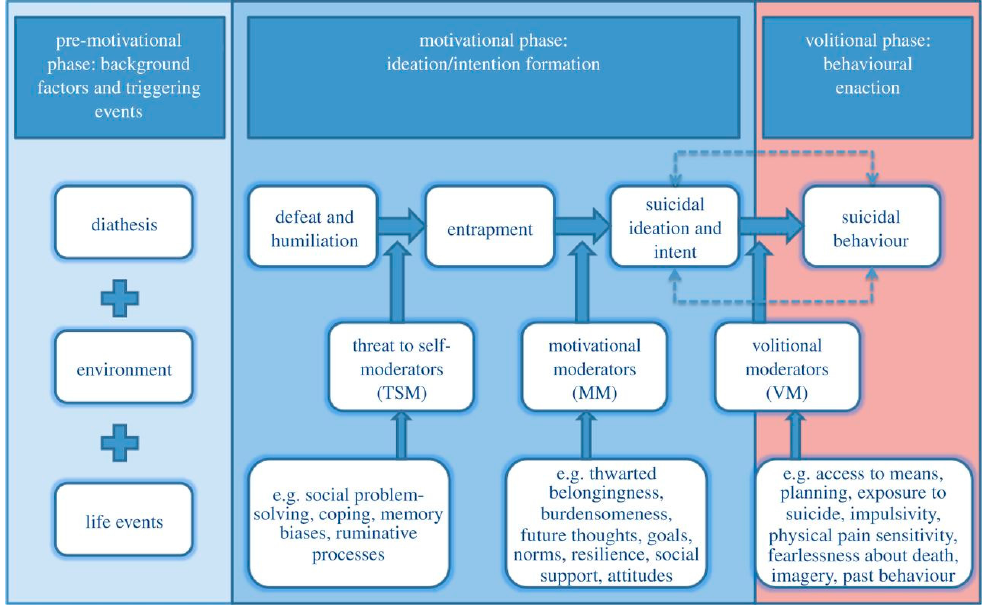
Figure 1. Visual representation of the integrated motivation–volitional model of suicidal behavior (IMV) [12].